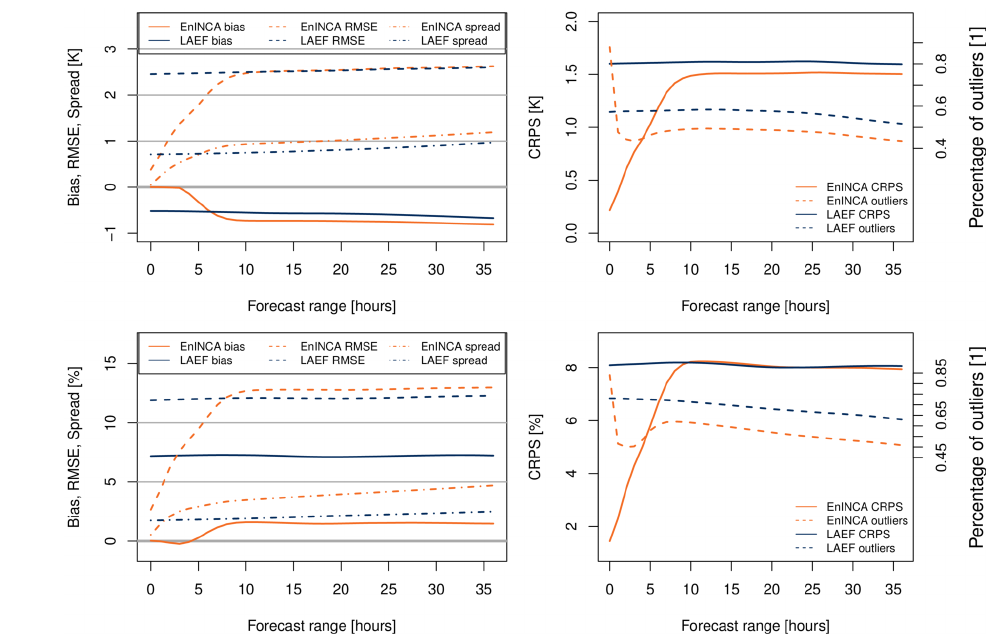
Figure 4. Various statistical measures for the one month long (January 2013) evaluation of 36-hour forecasts with En-INCA (orange) and LAEF (blue). Left panel: bias (solid lines), RMSE (dashed) and error spread (dash-dotted); Right panel: Continuous Ranked Probability Score (CRPS; solid) and percentage of outliers (dashed). Top row shows results for temperature, bottom row for relative